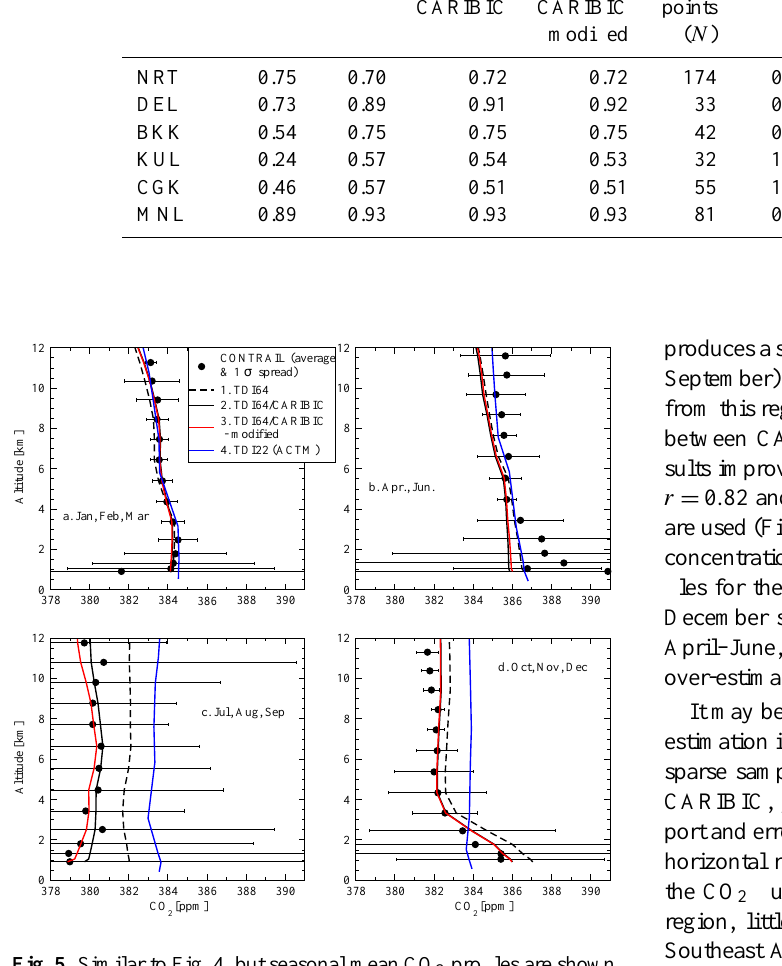
Fig. 5. Similar to Fig. 4, but seasonal mean CO 2 profiles are shown as the ACTM simulations at T42 horizontal resolution are not likely to capture individual CONTRAIL profiles over Delhi. Additionally, ACTM simulated vertical profiles using TDI22 inversion flux are shown here. CO 2 seasonal cycles at different height levels over Delhi are shown in Supplement Fig.